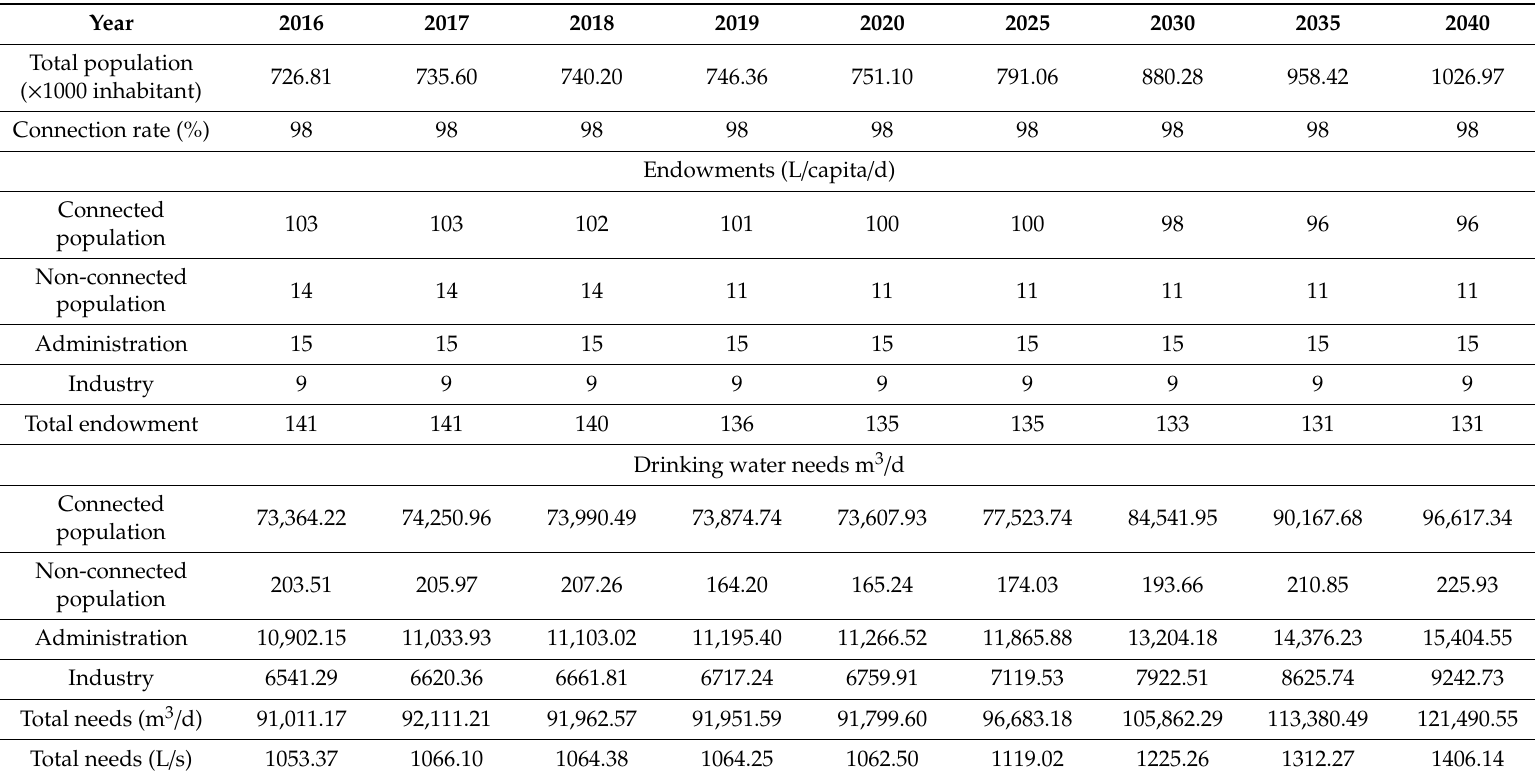
Table 1. Estimation of drinking water needs in Oujda